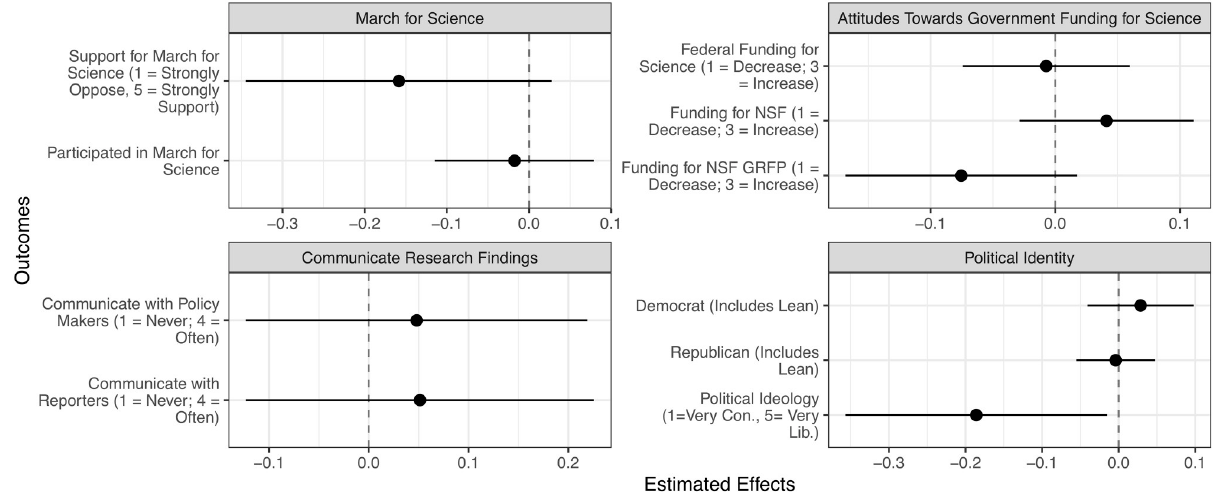
Fig 3. Effect of being awarded the NSF graduate research fellowship on political attitudes and behavior. N = 408. The error bars represent 95% confidence intervals calculated from the heteroscedasticity-consistent standard errors. S1 Data of S1 Table contains the effect estimates, standard errors, two-sided p -values, and baseline estimates.